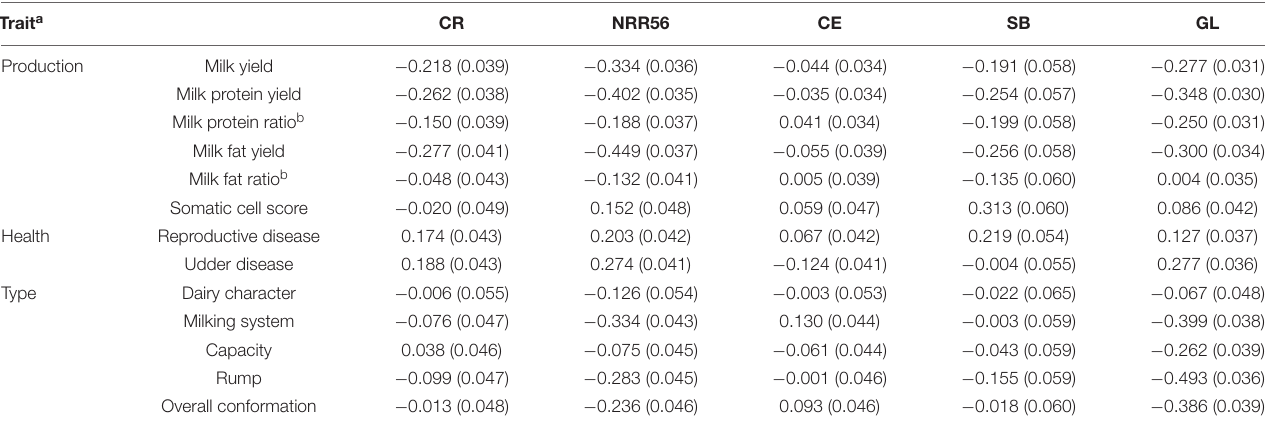
TABLE 3 | The correlations of breeding values for the genetic effects of service sire of reproductive traits and production, health, and type traits in Holstein cattle. Trait